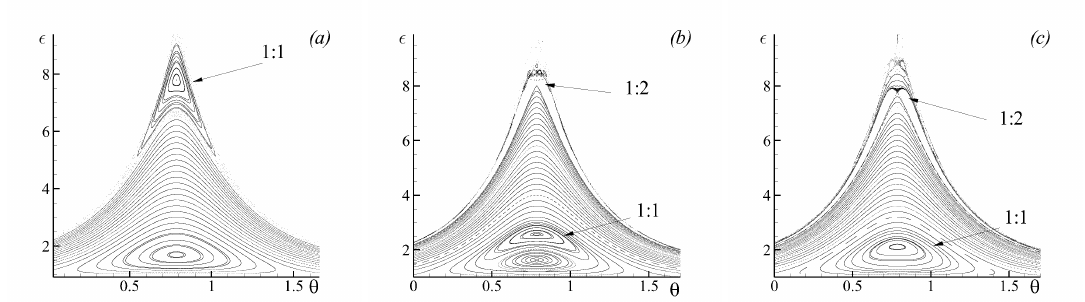
Figure 15. Poincaré maps detailing the drift of the stability island associated with the nonlinear resonance 1 : 1 as the perturbation frequency is increased: ( a ) 0.25; ( b ) 0.48; and ( c )